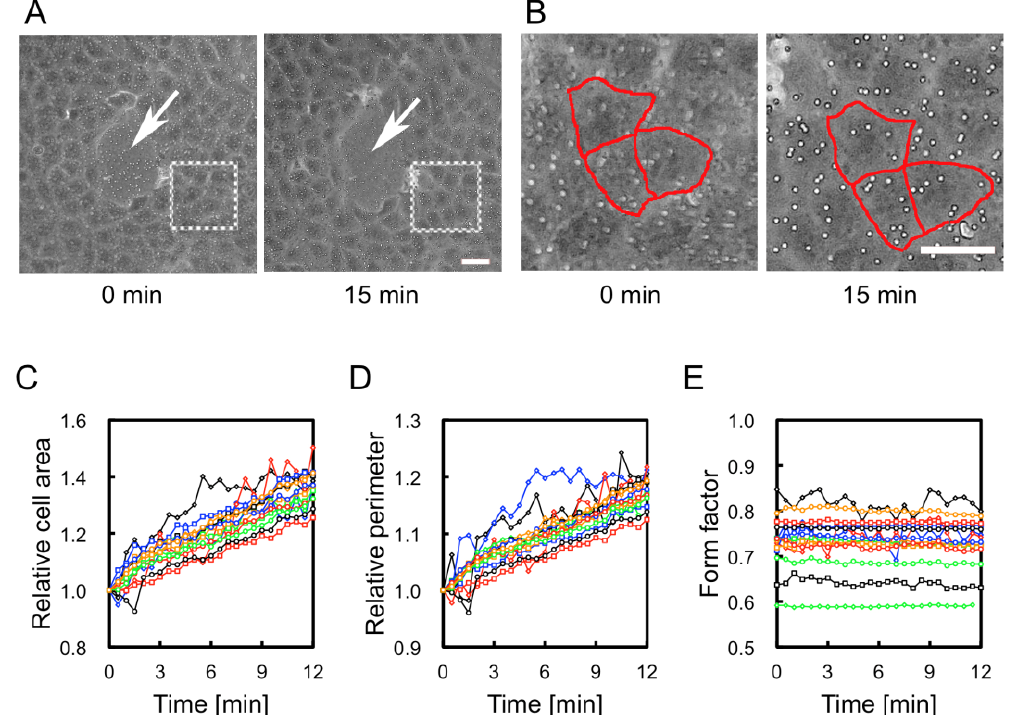
Figure 4. Observation and quantification of changes in cell shape during gel swelling. Cells cultured on the collagen-immobilized PNIPAAm gel side remained adhered